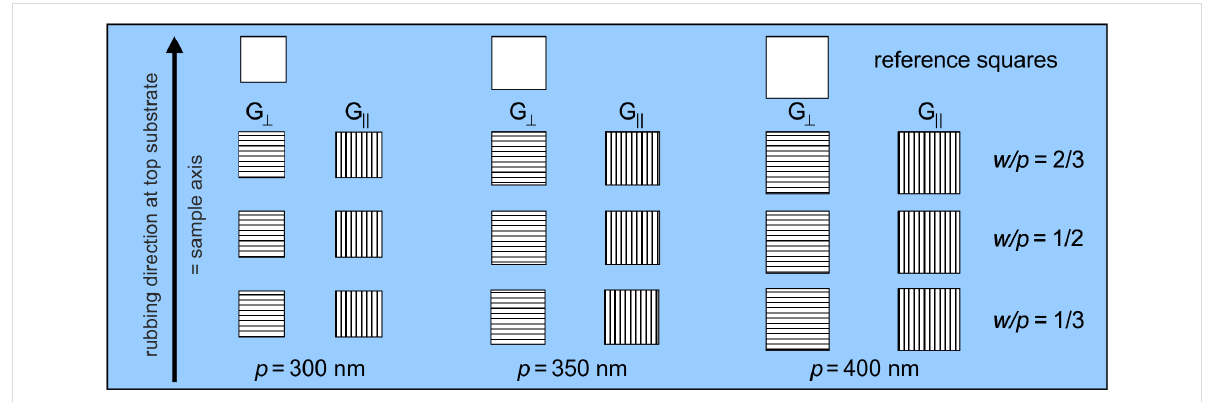
Figure 2: Schematic layout of the gratings on the sample; the arrow on the left indicates the rubbing direction of the top substrate to which the orien- tation of the grating slit is related.